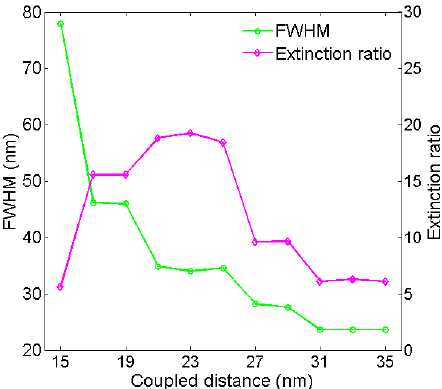
Figure 7. FWHM and extinction ratio as a function of coupling distance between waveguide and cavities for L = 320, w = 50 nm, and n d = 1.36048.